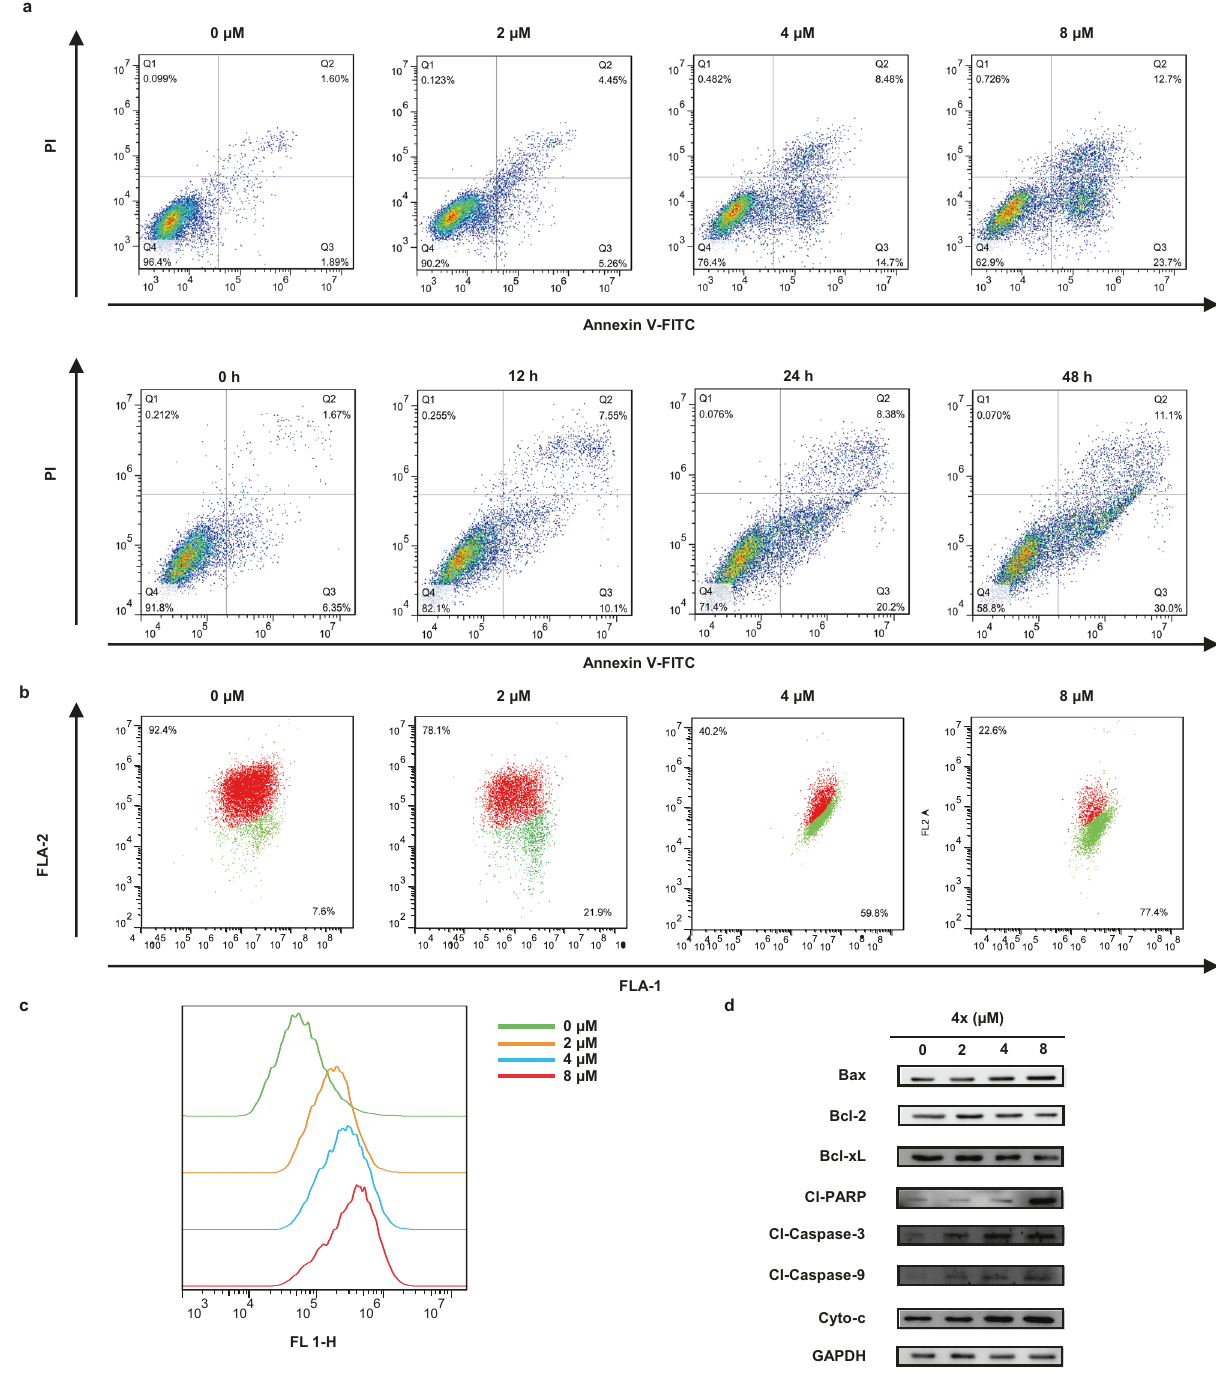
Fig. 6 Compound 4x induced apoptosis in A375 cells through the mitochondria-related pathways. a Compound 4x induced A375 cell apoptosis both in the dose- and time-dependent manners. b Compound 4x caused MMP loss in A375 cells in a dose-dependent manner. c Compound 4x elevated the ROS level in A375 cells in a dose-dependent manner. d The expression levels of apoptosis-related proteins were assayed by western blot analysis. Data are presented as the mean ± SD from three independent